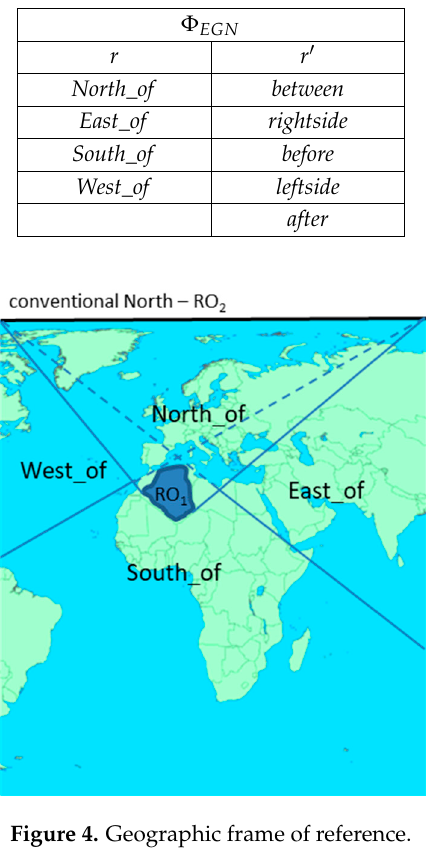
Figure 4. Geographic frame of reference.